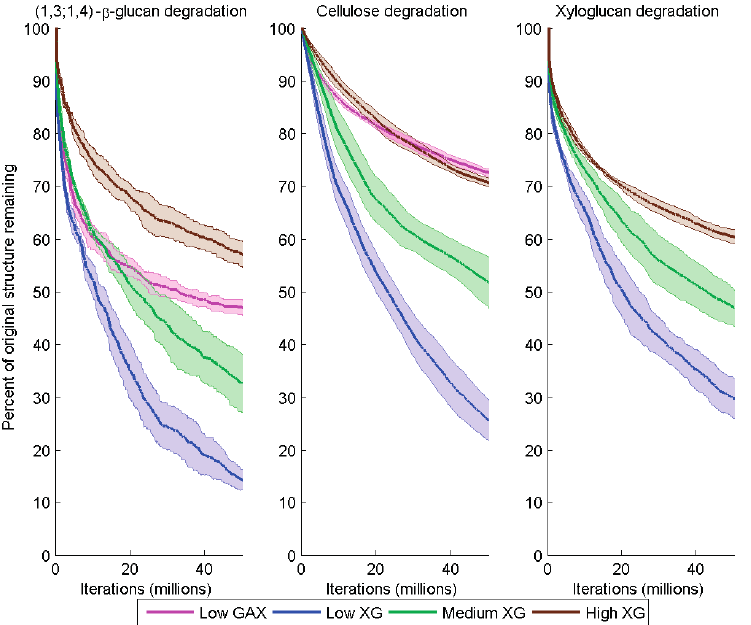
Figure 5. Degradation of (1,3;1,4)- β -glucan, cellulose and XG over time (iteration) for the different model cell walls as a consequence of combined Cel51A and Cel9D activity. Degradation is shown as the number of backbone glycosyl residues remaining expressed as a percent of the initial number, calculated as a mean (solid line) and 95% confidence band (shaded region) from five replicate simulations per